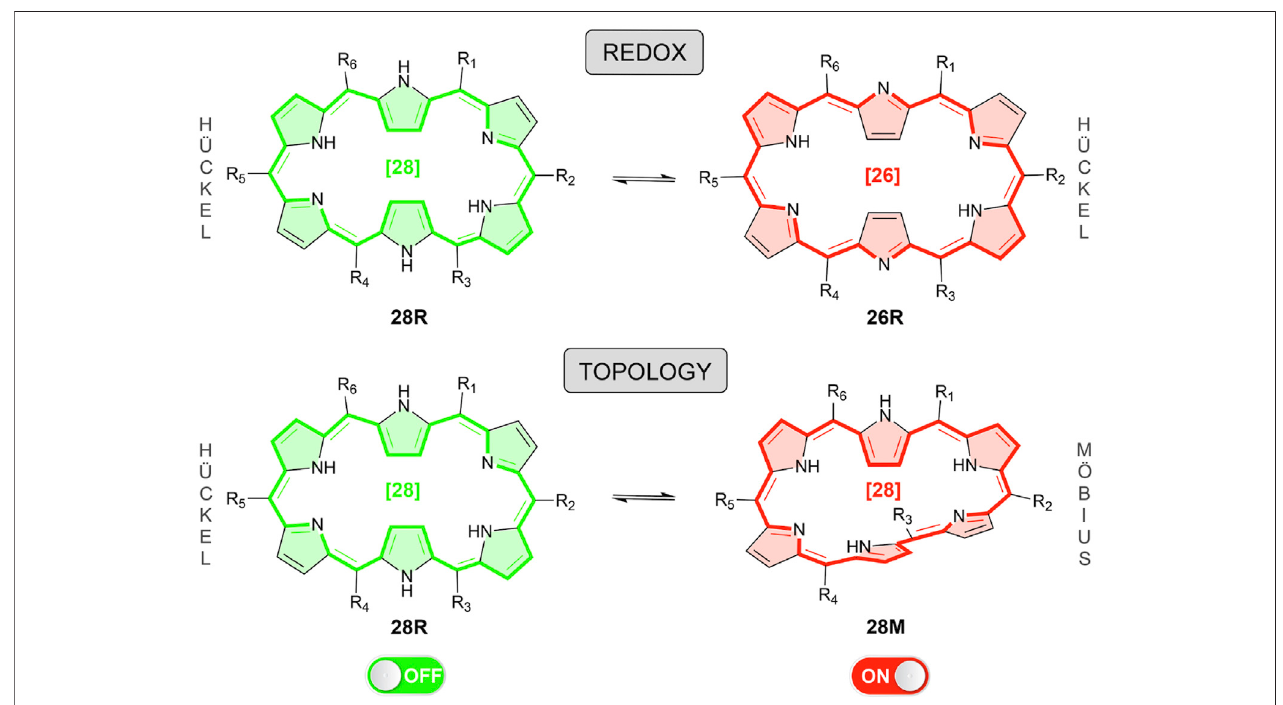
SCHEME 1 | Overview of the redox and topology switches based on hexaphyrins. Inverse design is applied to optimize the functionalization of both molecular switches by maximizing the NLO contrasts. Red fi ve-membered rings are linked to aromatic structures, whereas green ones to antiaromatic con fi gurations.